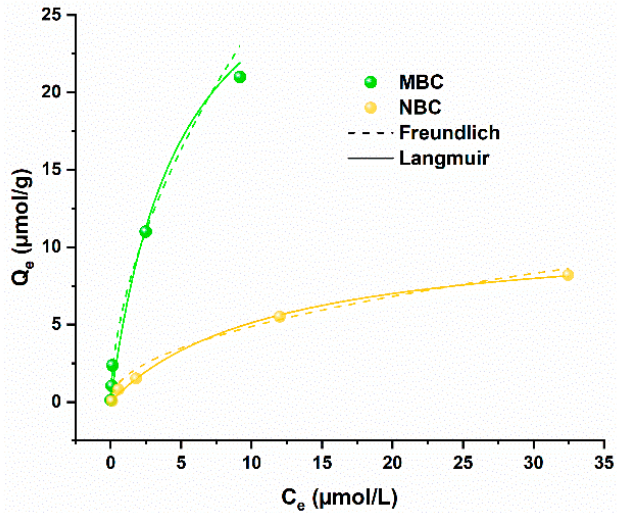
Figure 3. Adsorption isotherms of MBC (in green) and NBC (in yellow) in Pb solution in ultrapure water. Freundlich and Langmuir isotherm models are depicted as dashed and solid lines,